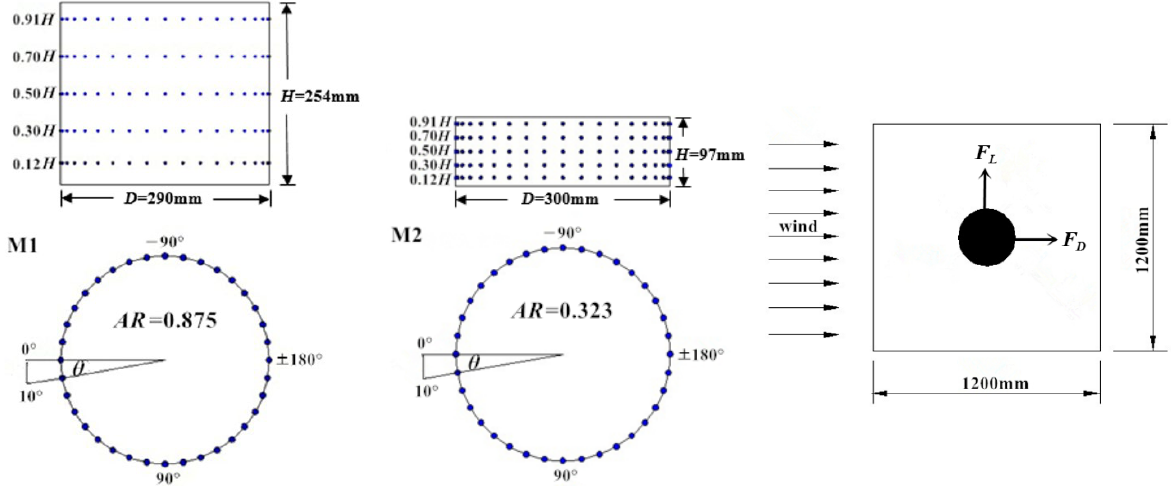
Figure 2. Experiment setup in the wind tunnel.